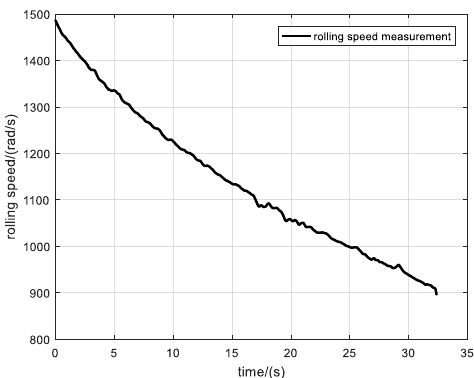
Figure 15. Rotational speed calculated using the zero-crossing method.